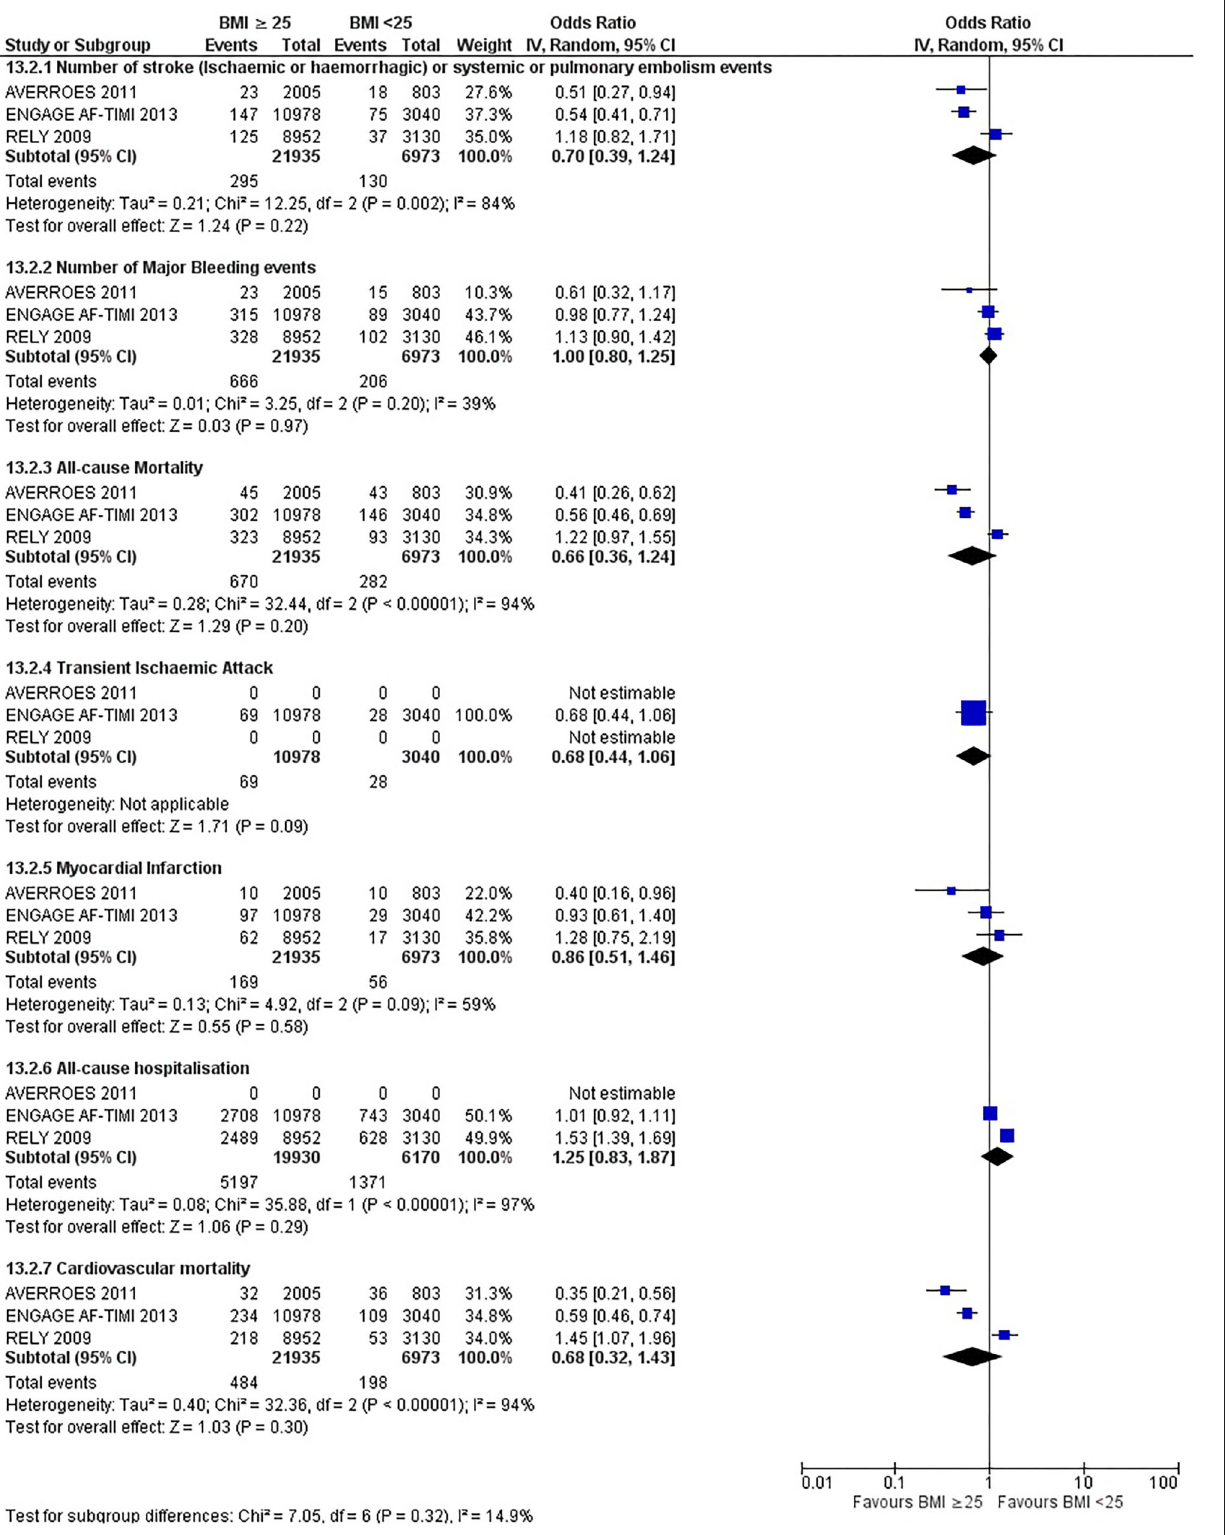
FIGURE 2 | Forest plot of comparison: BMI ≥ 25 vs. BMI < 25 at 12 months.